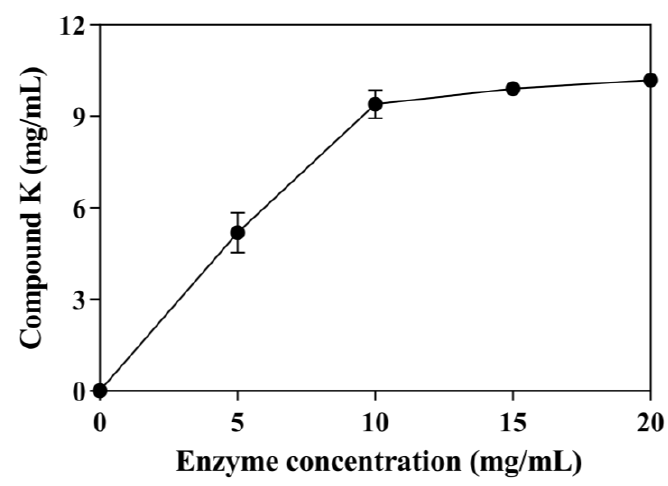
Figure 4. Effect of enzyme concentration on the production of CK. The reactions were performed at 80 °C in acetate buffer (50 mM and pH 6.0) containing 30 mg/mL ginsenoside substrate in the presence of 3 mM LiCl by varying the enzyme concentration from 0 to 20 mg/mL for 48 h. Experiments were performed in triplicate. The data represent the means of replicates and the error bars represent standard deviations.